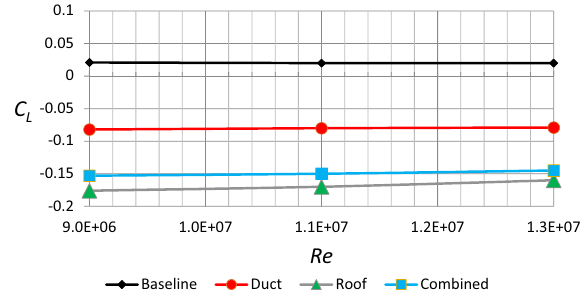
Figure 20. Lift coefficient as a function of Reynolds number for different configurations of Discovery car.